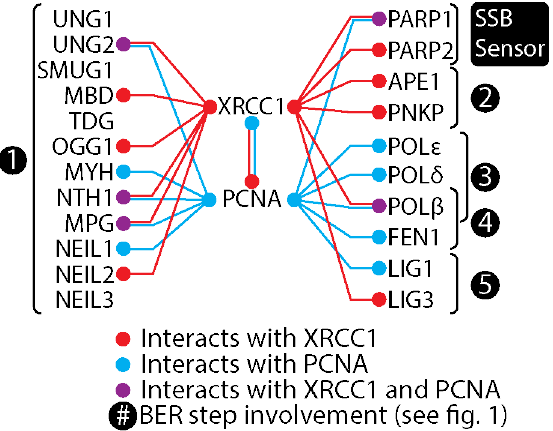
Scaffold protein interactions in BER. Common and separate interactions of XRCC1 and PCNA with enzymes involved in